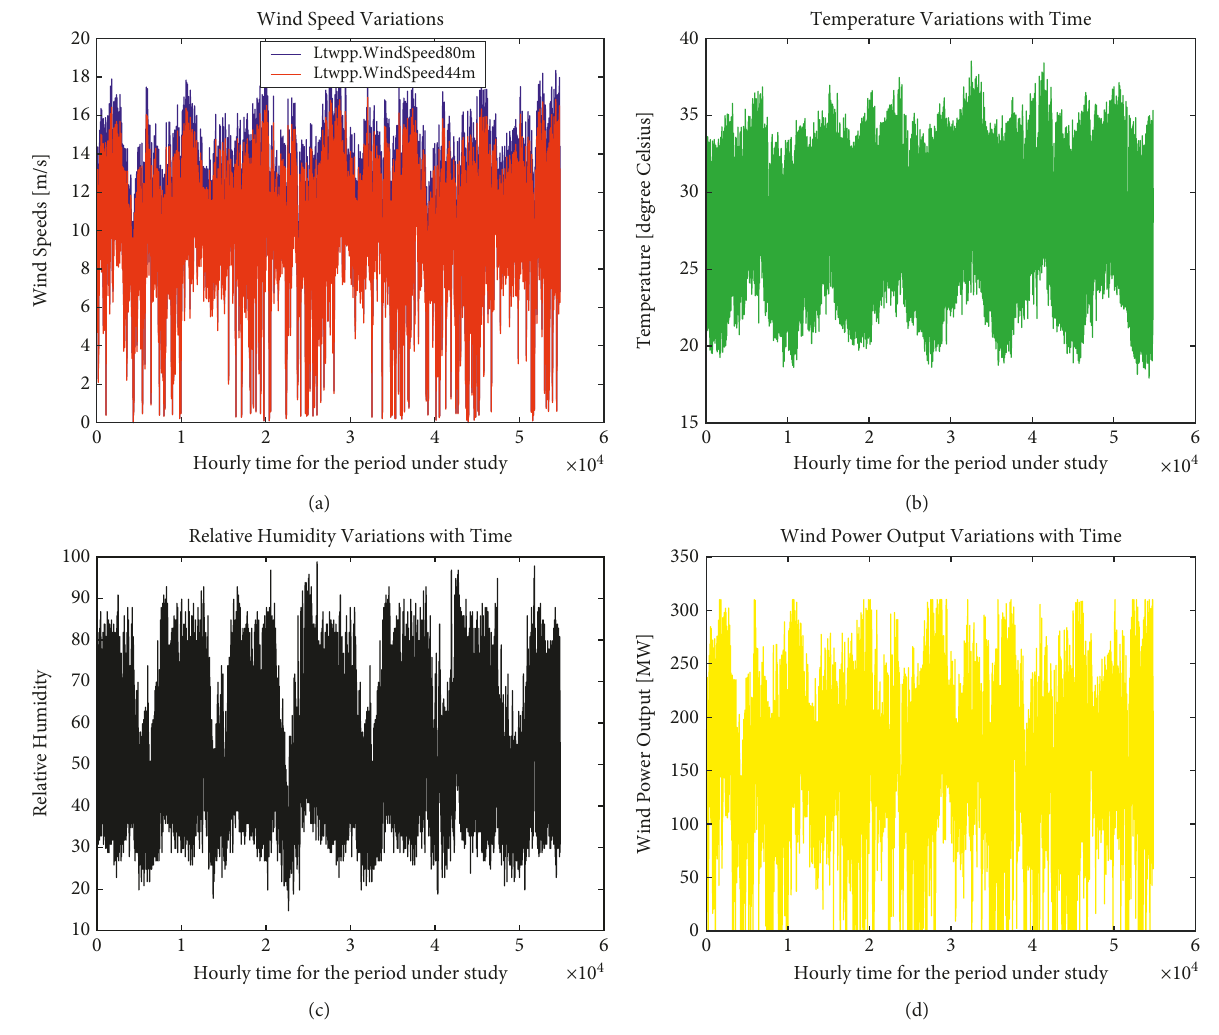
Figure 9: Preprocessed wind data for the time period under the